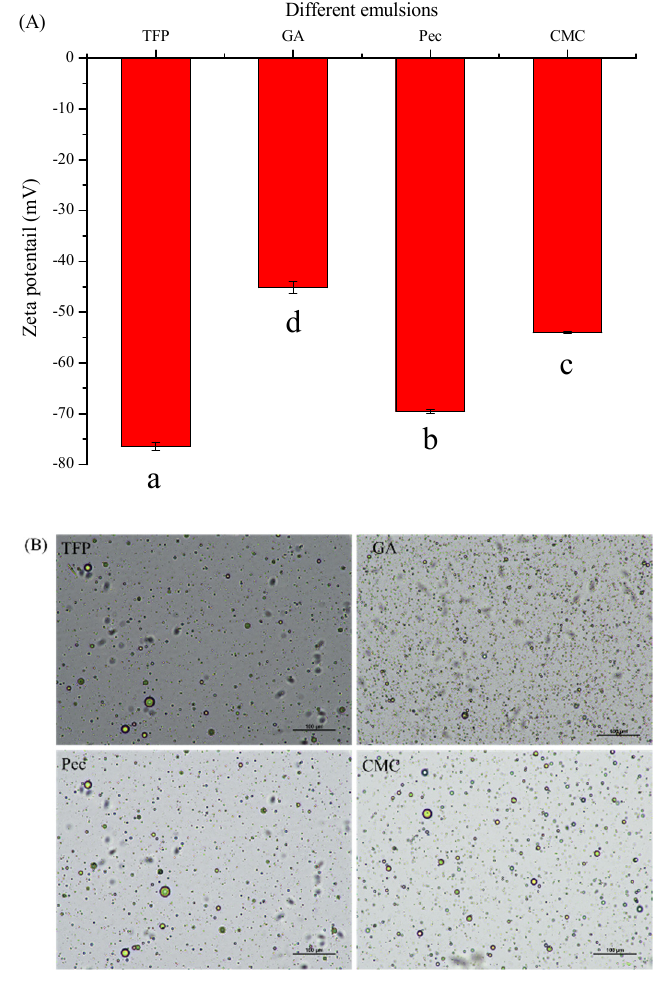
Figure 3. Optical microscopy ( A ) and zeta-potential ( B ) of different emulsions. (Different lowercase letters in ( A ) indicate a significant difference of zeta potential at p < 0.05).